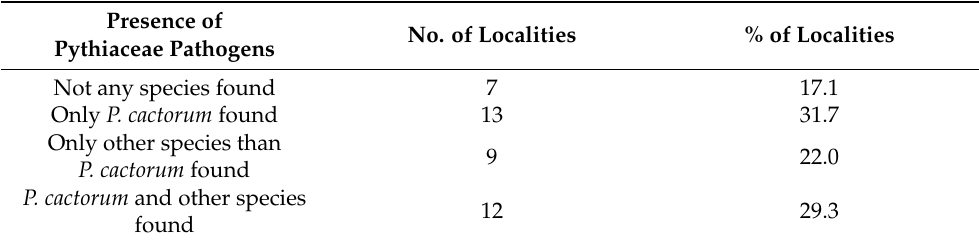
Table 2. The numbers and percentages of strawberry farms in the Czech Republic in which P. cactorum and other species of the order Peronosporales were